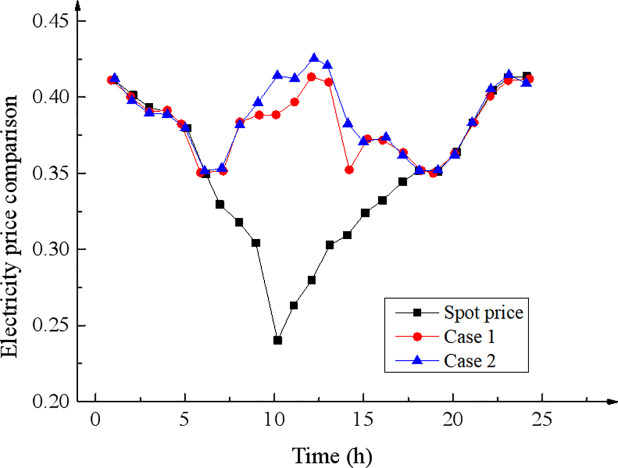
Comparison results of incentive electricity prices based on Case 1 and Case 2.